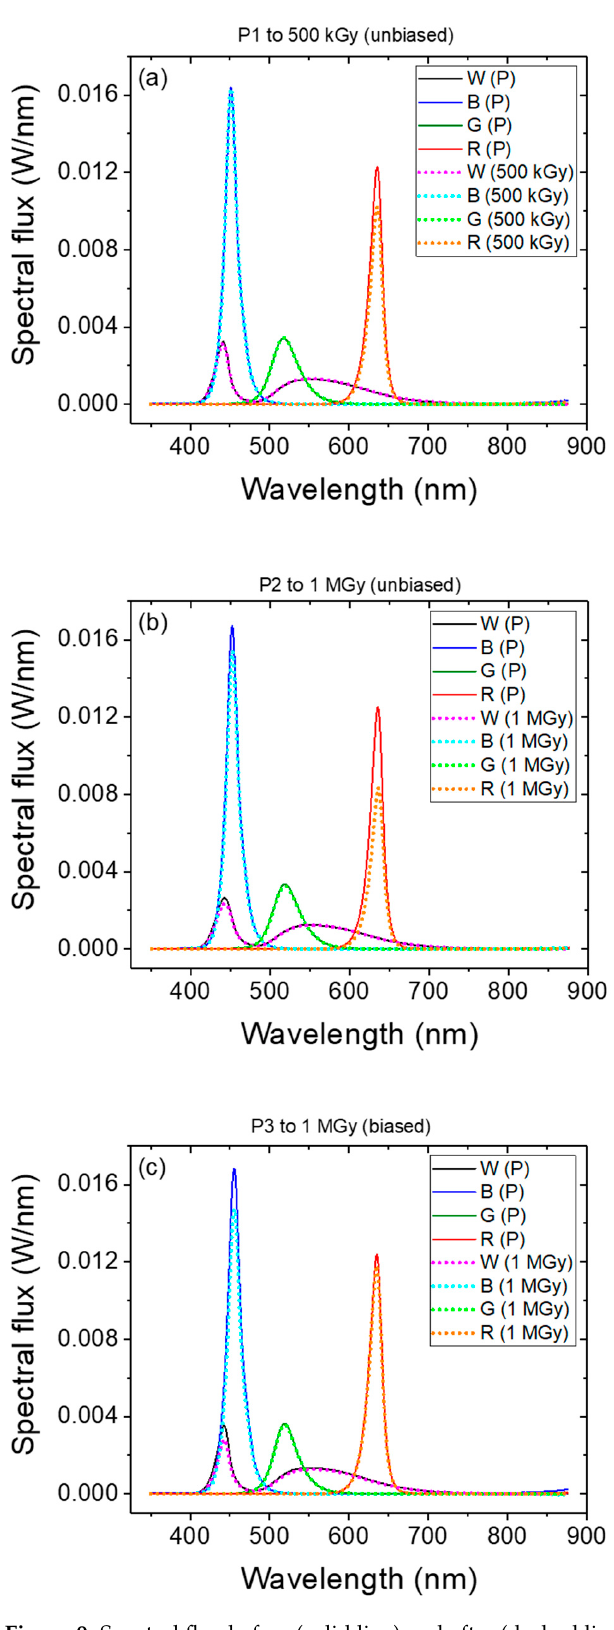
Figure 9. Spectral flux before (solid line) and after (dashed line) irradiation for our P1 ( a ), P2 ( b ) and P3 ( c ) samples. The different LED colors are reported in the legend: white (W), blue (B), green (G) and red (R).